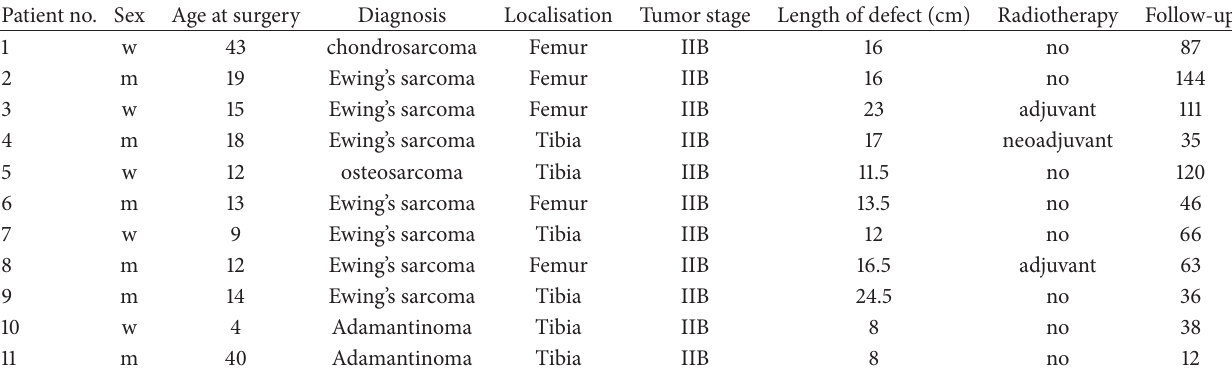
Table 1: Patient characteristics: tumor resection and reconstruction with a bilateral fibular graft ( 𝑛 = 11). Patient no.